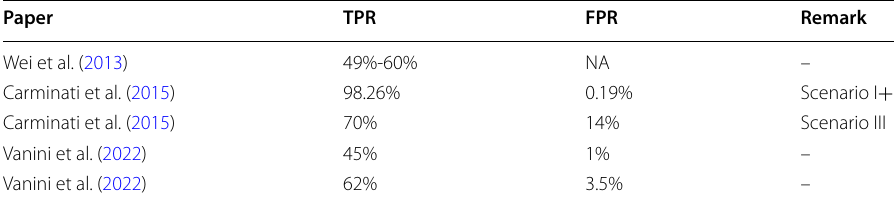
TPR means True Positive Rate and FPR the False Positive Rate